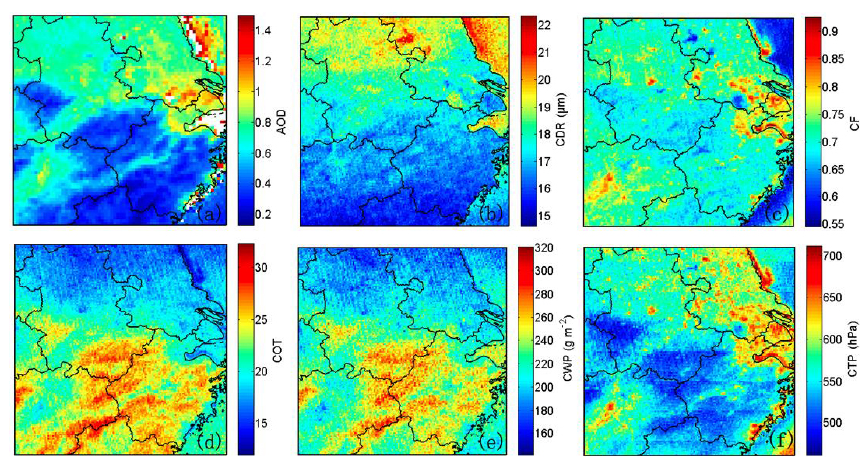
Figure 2. Spatial distributions of AOD (a) , CDR (b) , CF (c) , COT (d) , CWP (e) and CTP (f) averaged over all years between 2007 and 2010.